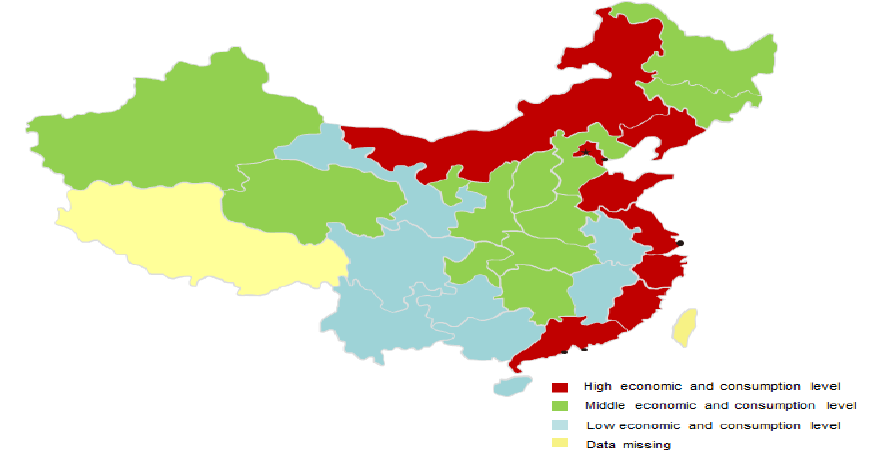
Figure 3. Clustering results of 30 provinces according to economic and consumption